Question: Express in one sentence what the figure is showing.
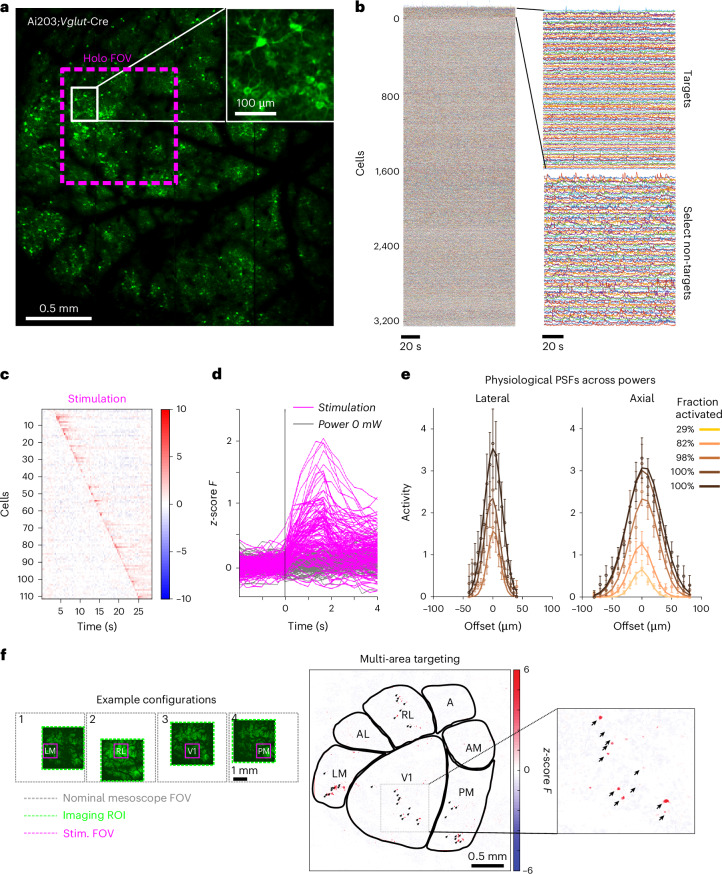
Answer: 2p holographic optogenetics at the mesoscale. a , A 2p mesoscale image of widespread co-expression of GCaMP7s and ChroME over a large FOV in a Vglut1 -Cre; Ai203 transgenic mouse. The magenta square indicates the accessible holographic FOV within an example mesoscale imaging FOV of 2.4 mm × 2.4 mm recorded at a 4.5 Hz frame rate. b , Example single-trial calcium traces from a set of photostimulation targets within the holographic FOV and thousands of traces from non-targets recorded across the mesoscale FOV. c , Calcium responses of targeted cells during single-cell sequential targeting on stimulation trials (right). Photostimulation with five pulses (5 ms, 30 Hz, 75 mW). Traces averaged over five trials. d , Stimulus-aligned target cell responses across the holographic FOV ( n = 111 cells). Single-trial traces. e , In vivo optically measured lateral (left, n = 20 cells) and axial (right, n = 32 cells) physiological point-spread functions as a function of stimulation power. The y axis indicates neural activity measured as Δ F (see Methods ). Absolute powers used are 0.5 mW, 1 mW, 2 mW, 4 mW and 8 mW in a CaMK2 -tTA; tetO-GCaMP6s mouse, corresponding to a fraction of activated cells among targeted cells of 29%, 82%, 98%, 100% and 100%, respectively (see Extended Data Fig. 4 ). The filled circles represent the actual means across cells; error bars, s.e.m.; the solid traces are weighted Gaussian fits. For lateral PPSFs, fitted FWHMs are 28.5 µm, 31.9 µm and 38.4 µm at 2 mW, 4 mW and 8 mW, respectively. For axial PPSFs, fitted FWHMs are 35.4 µm, 46 µm, 59.8 µm, 66.4 µm and 70.4 µm at 0.5 mW, 1 mW, 2 mW, 4 mW and 8 mW, respectively. f , Demonstration of sequential area mesoscale holographic stimulation. Left, four example configurations to holographically target four different visual areas within the same session and record from surrounding visual areas. Imaging ROIs were selected for a 3 Hz imaging rate at 1 µm per pixel. Photostimulation with a single 250 ms pulse, 80